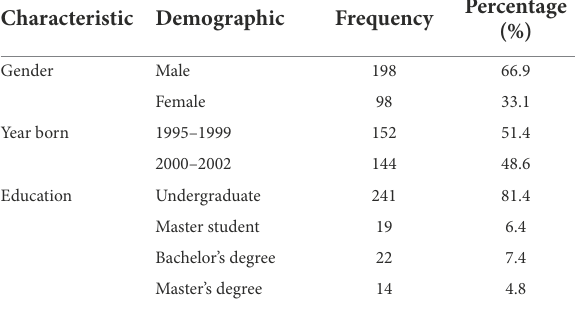
TABLE 2 Confirmatory factor analysis.